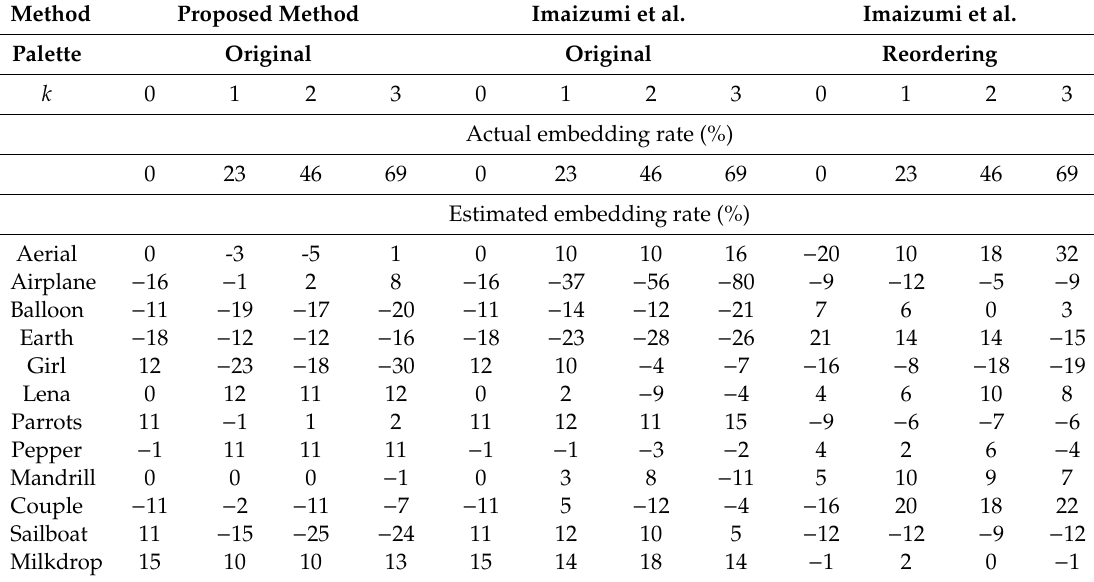
Table 6. The results of RS steganalysis for Imaizumi et al.’s [16] and the proposed methods with block size 2 ×